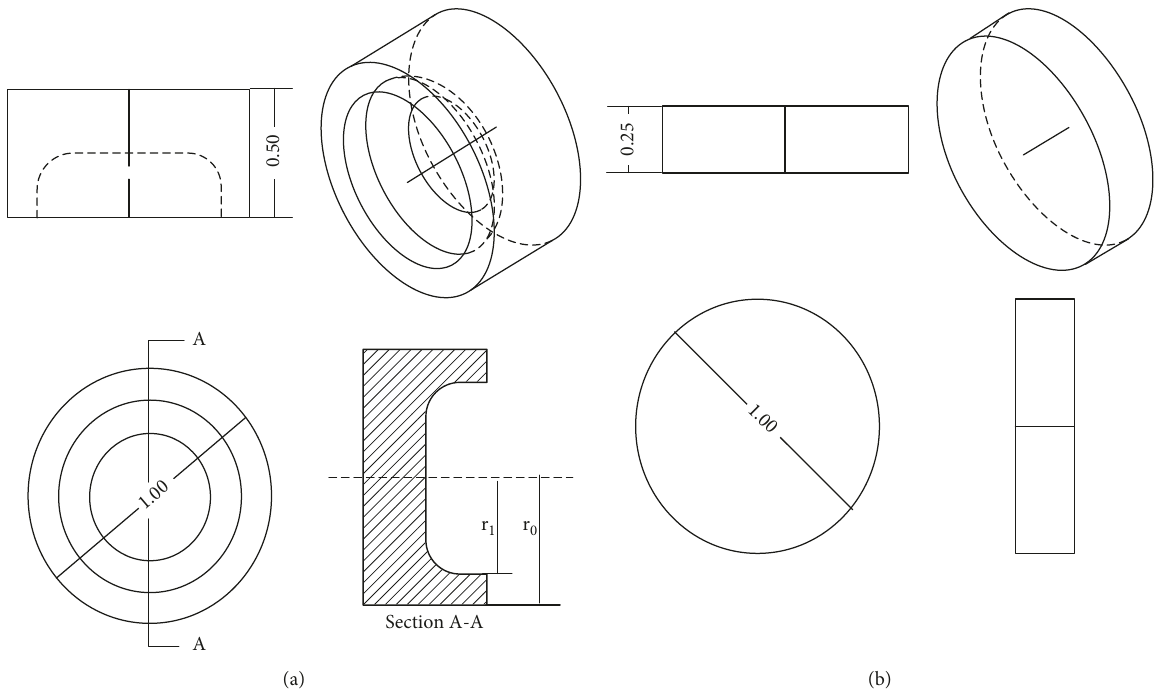
Figure 19: Friction specimen designed by Espinosa et al. [70]: (a) u-shaped disk attached to the incident bar and (b) disk attached to the transmission bar.